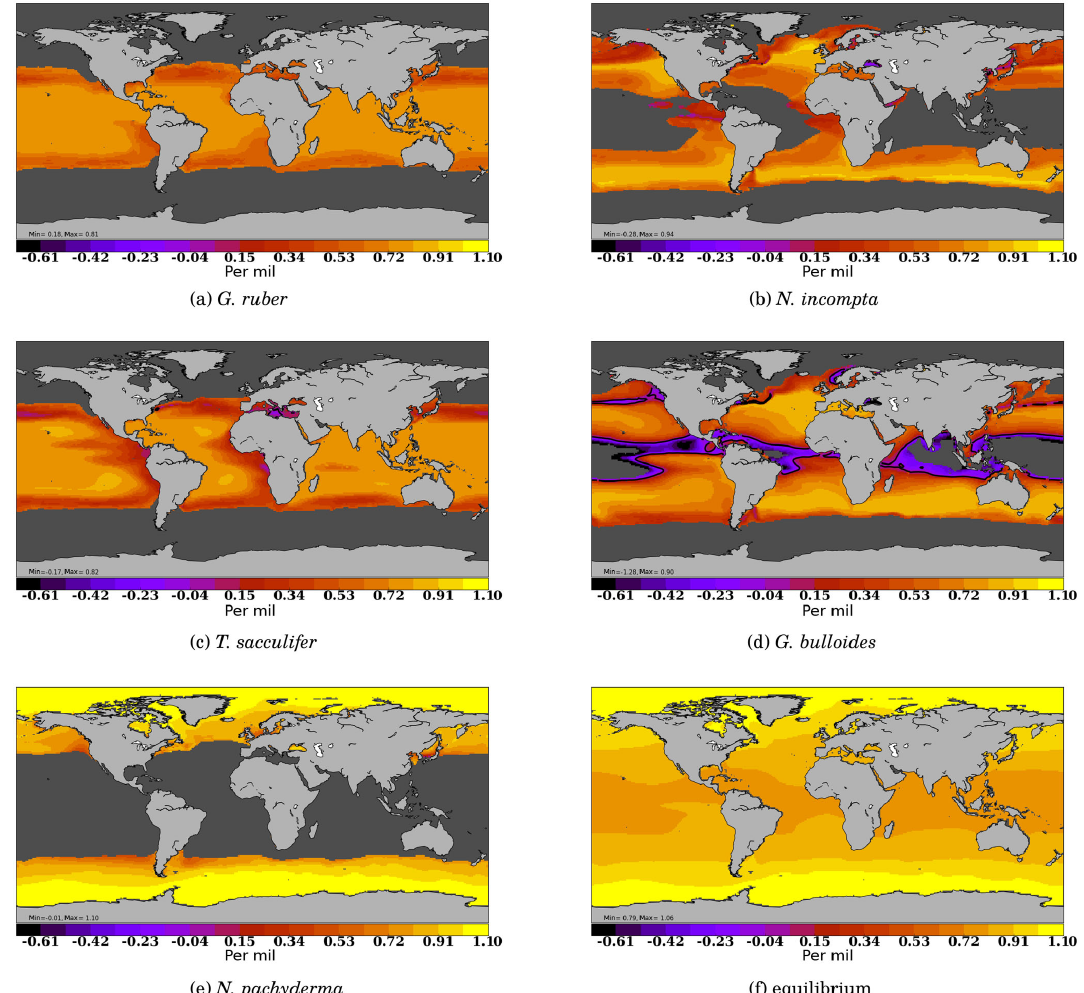
Figure 6. δ 18 O c response to a horizontally and vertically homogeneous 4 ◦ C cooling applied to the WOA13 dataset, (cid:49) 18 O c . Results are expressed in permil for each species (a–d) and for the equilibrium surface calcite